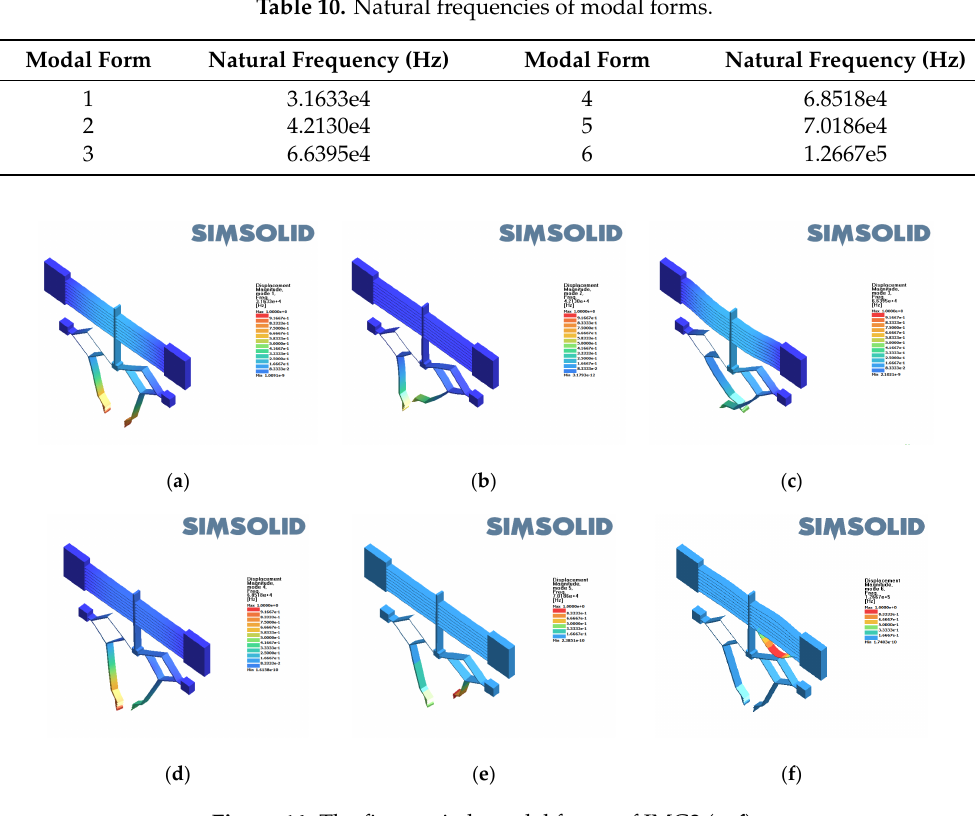
Figure 14. The first to sixth modal forms of IMG2 ( a – f ).